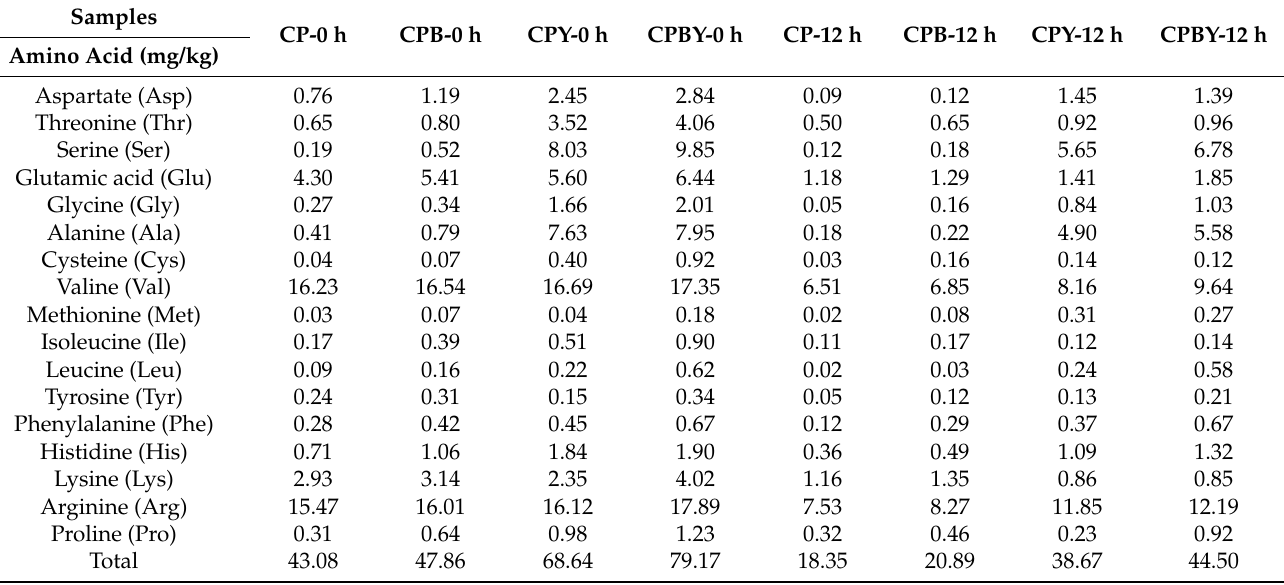
Table 1. Variations in the level of free amino acids before and after